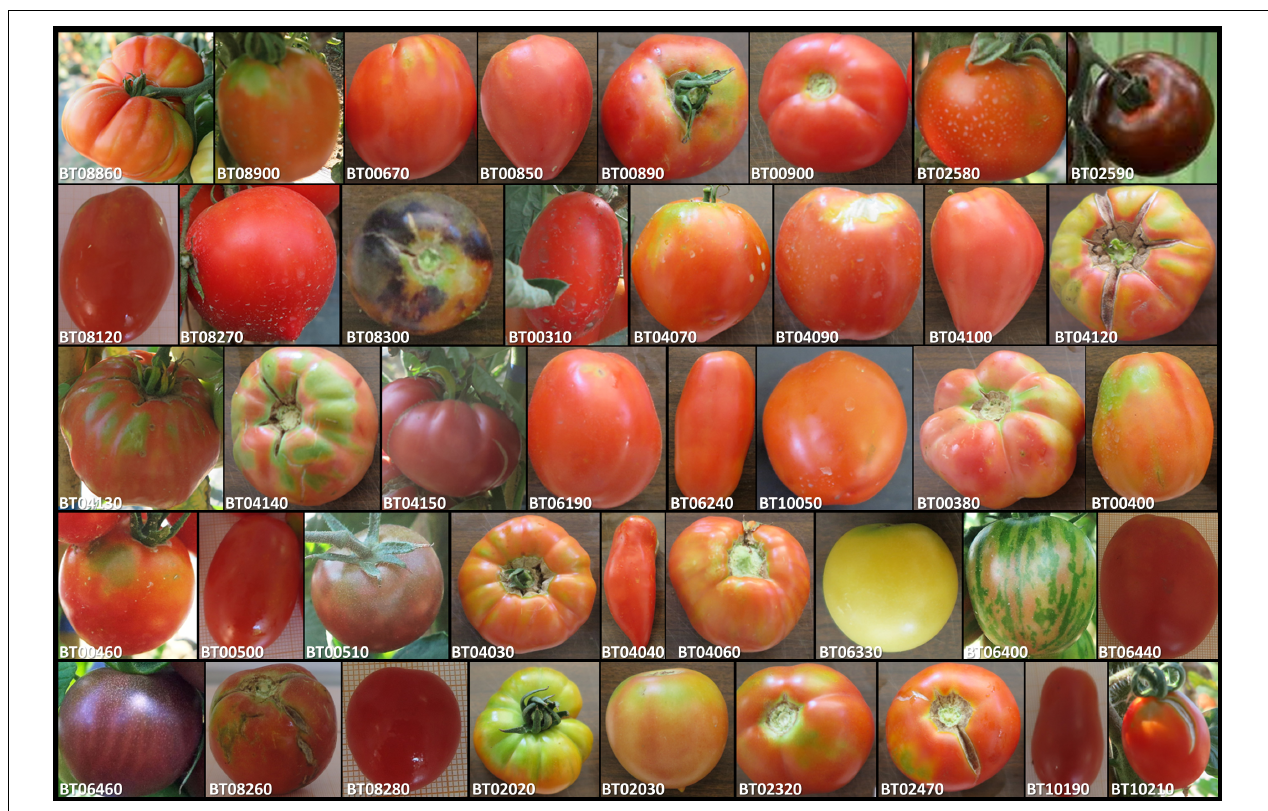
FIGURE 1 | Fruit morphological diversity of the 42 accessions evaluated in two organic farms under nitrogen and water stress conditions in this study. BL = Breeding lines, CL = Elite cultivars, FM = Landraces for the fresh market, HL = Heirlooms, LS = Long shelf-life cultivars. Additional details in are Supplementary Table 1 . The pictures are not in the same scale.